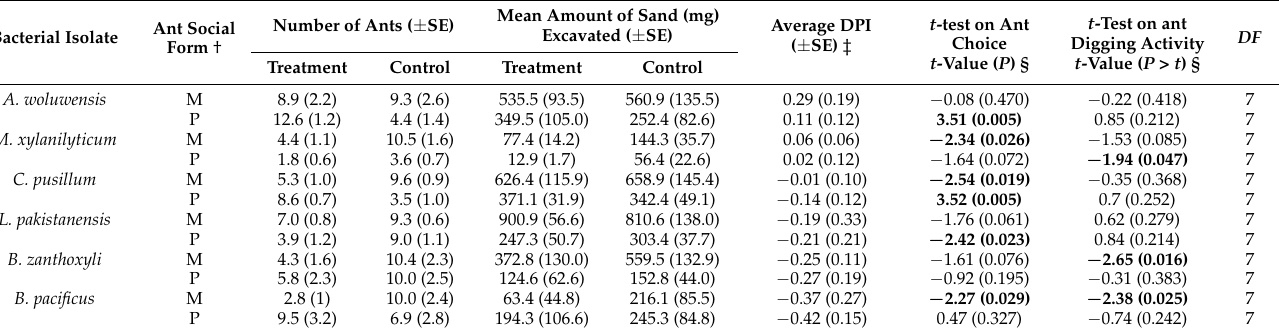
Table 6. Effects of soil-derived bacterial isolates presented at 5 × 10 6 cells/mL densities on monogyne and polygyne S. invicta location and digging activity in bacteria-treated or control sand and digging preference index (DPI) after 18